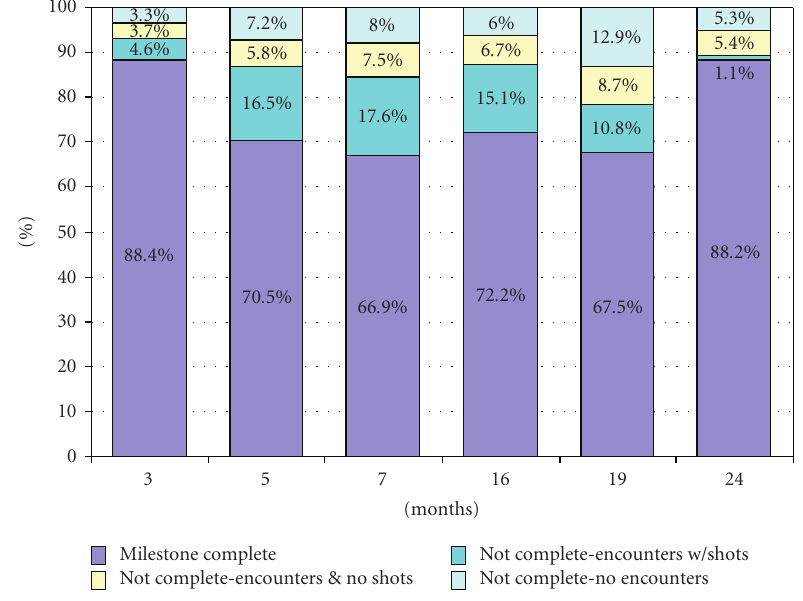
Figure 4: Milestone Completeness and Provider Encounters for Children UTD for 4:3:1:3:3:1 Series by 24 to 35 Months.